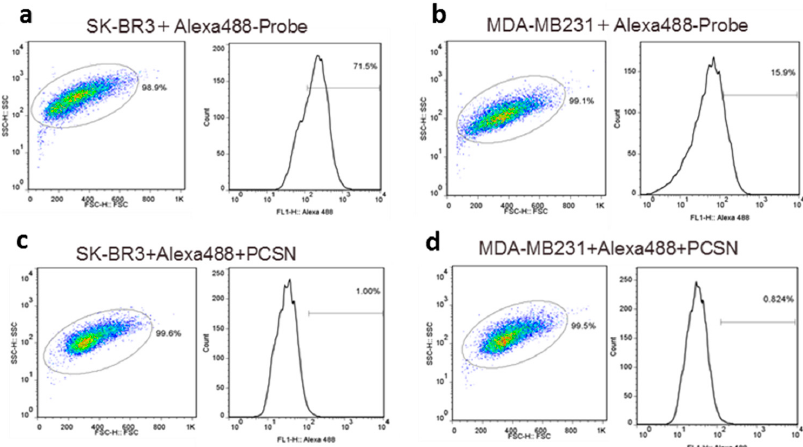
Figure 3. Flow cytometry analysis of HER2-targeted PCSNs. HER2-targeted PCSNs reveals a higher percentage of fluorescent cells in the SK-BR3 cell population ( a ) than in the MDA-MB231 cell population ( b ) and in the non-targeted PCSN controls composed of SK-BR3 cells ( c ) and in the MDA-MB231 cells ( d ). Each cell is represented by a dot and the red/yellow/green/blue hotspots indicate increasing cell populations.